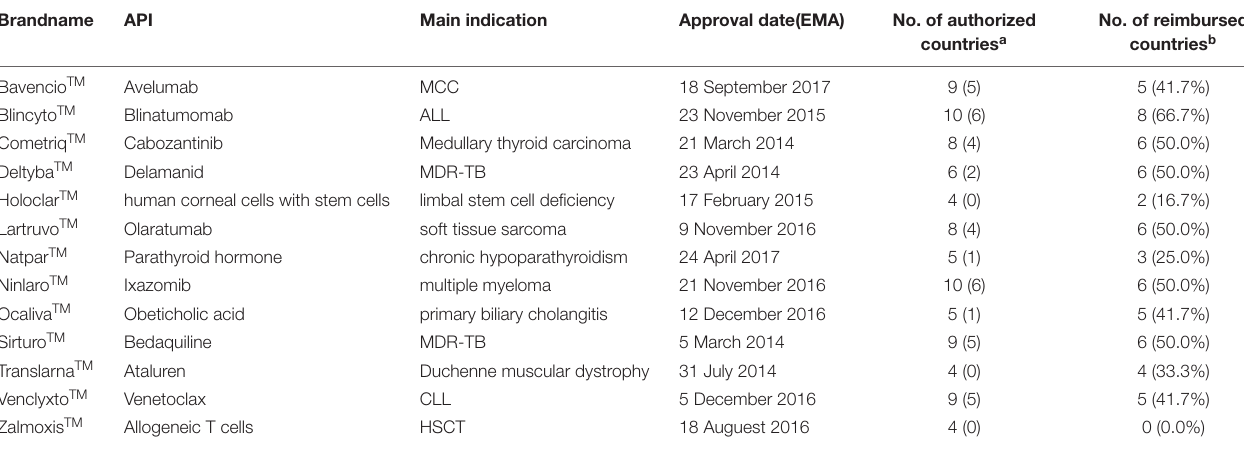
TABLE 1 | Basic information of the selected